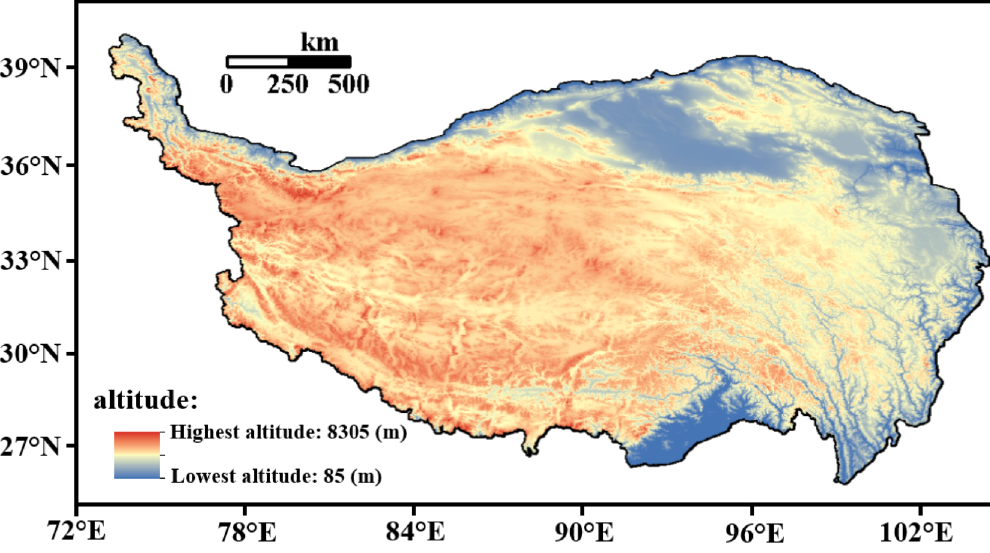
Figure 1. The altitude of the Qinghai-Tibet Plateau. (Software: ArcGIS 10.5, https:// www. arcgis. com/ index.